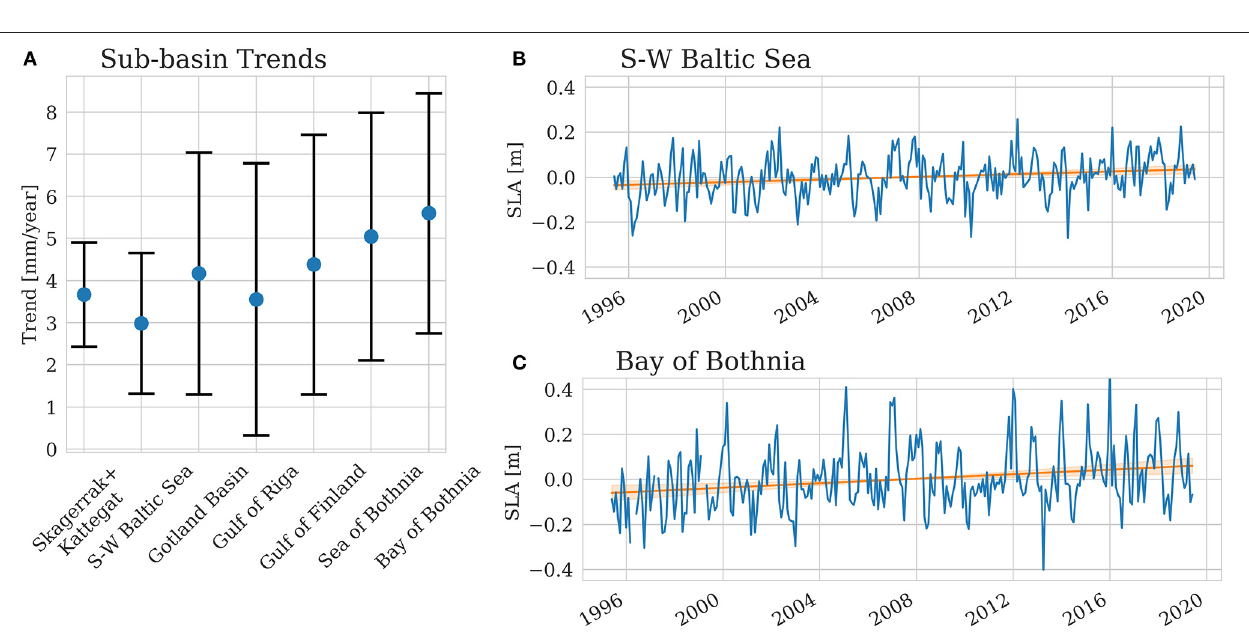
FIGURE 5 | Histograms of the differences in estimated SL trends from gridded altimetry (SAT) and TGs, compared using the closest point. Each panel correspond to different SAT dataset: the altimetry dataset from May 1995 to December 2018 developed in this study ( A , Baltic+), the altimetry dataset from May 1995 to December 2018 CMEMS ( B , Copernicus), the altimetry dataset from May 1995 to December 2015 developed in this study ( C , Baltic+), the altimetry dataset from May 1995 to December 2015 of the SLCCI ( D , SLCCI).